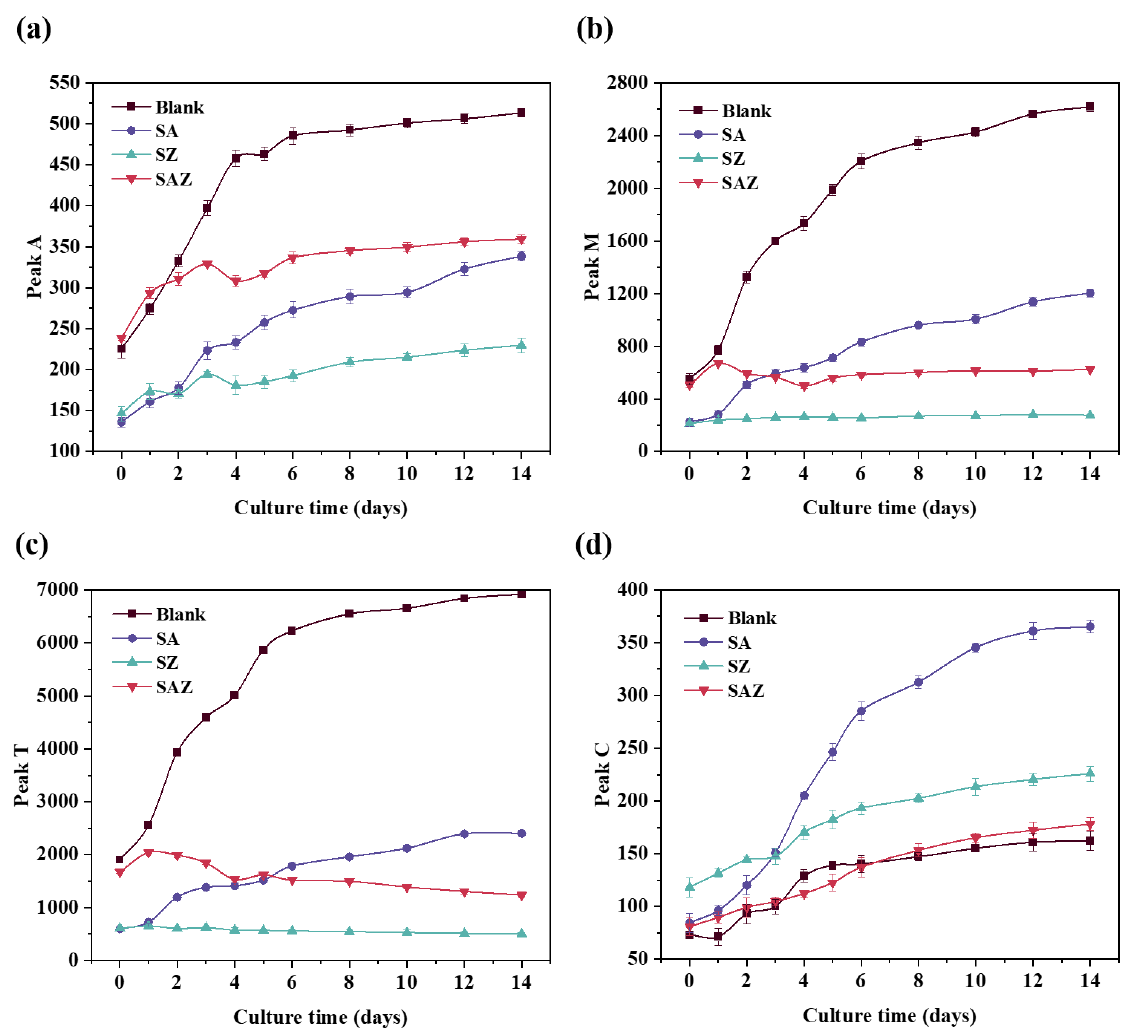
Figure 5. Changes in fluorescence peaks of S. dohrnii in the different treatments during the culture time. ( a – d ) are represented as peaks A, M, T, and C, respectively. Error bars represent the standard error for duplicate cultures. Note error bars are smaller than the symbol sizes in some cases.